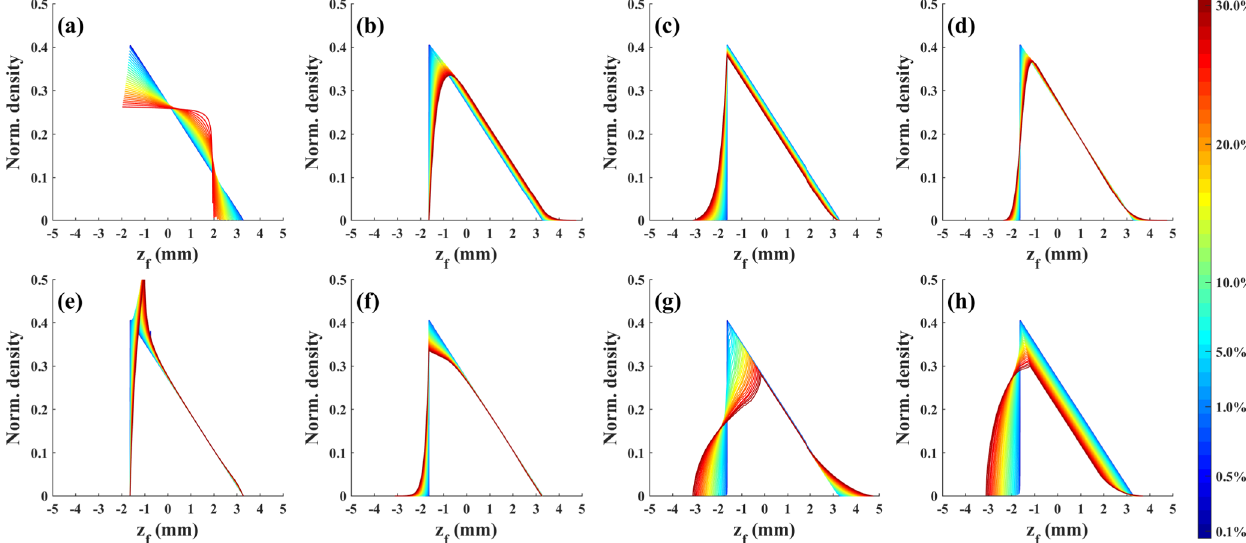
FIG. 7. The perturbed longitudinal bunch shapes for: x 2 0 -series with C 1 < 0 (a), z 2 0 -series with C 4 > 0 (b) and C 4 < 0 (c), x 0 z 0 -series with C 7 ≠ 0 (d), y 2 0 -series with C 11 > 0 (e) and C 11 < 0 (f), SC effect (g), and CSR effect (h). The color corresponds to the ratio of the =l to the ideal bunch length ( l b ): ζ maximum deviation ζ b . max max